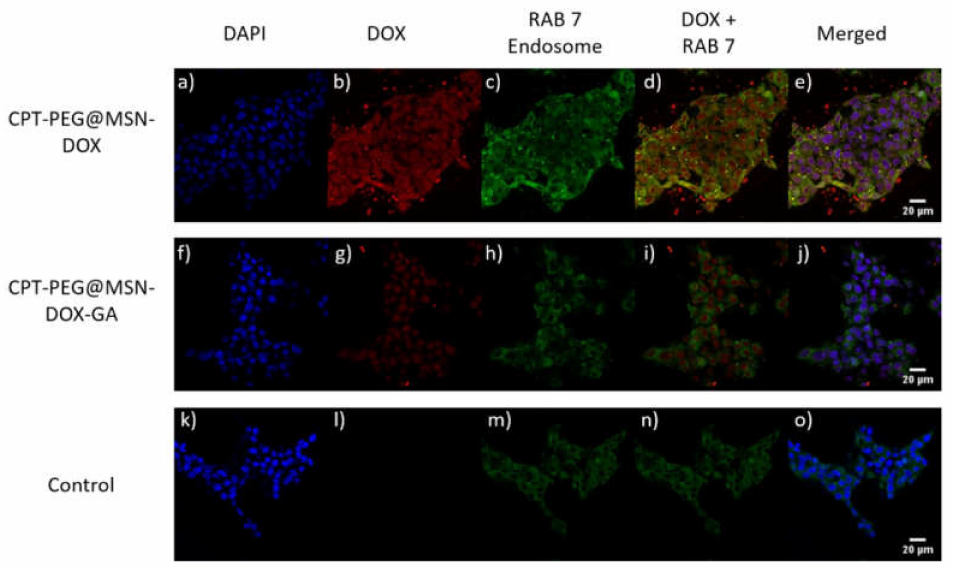
Figure 6. Confocal laser scanning microscopy (CLSM) images of the uptake for 1 h of CPT-PEG@MSN-DOX and CPT-PEG@MSN-DOX-GA (100 µ g · mL − 1 ) at 37 ◦ C for 1 h at 100 µ g · mL − 1 . Scale bar 20 µ m. Blue: DAPI, red: DOX, green: